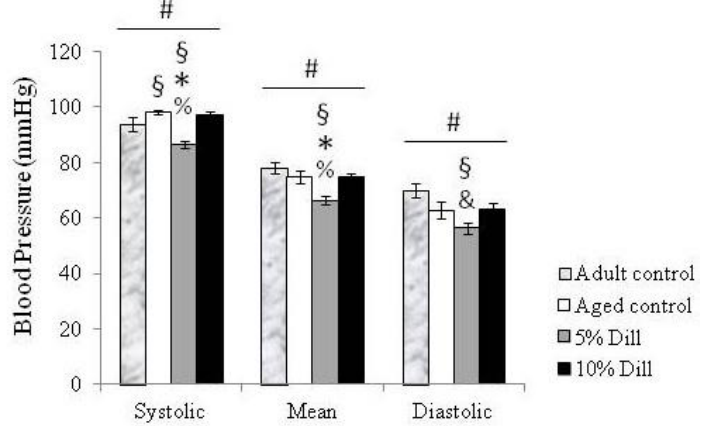
Figure 1. Systolic, mean, and diastolic arterial blood pressure in control (untreated) and DE-treated aged mice. Values are mean ± SEM. Control: untreated animals. Dill: DE-treated animals. # Significant e ff ect of treatment (one-way ANOVA, p ≤ 0.05). § Significant di ff erence with untreated adult mice